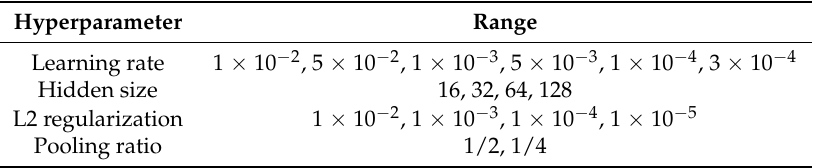
Table 1. The grid search space for the hyperparameters.